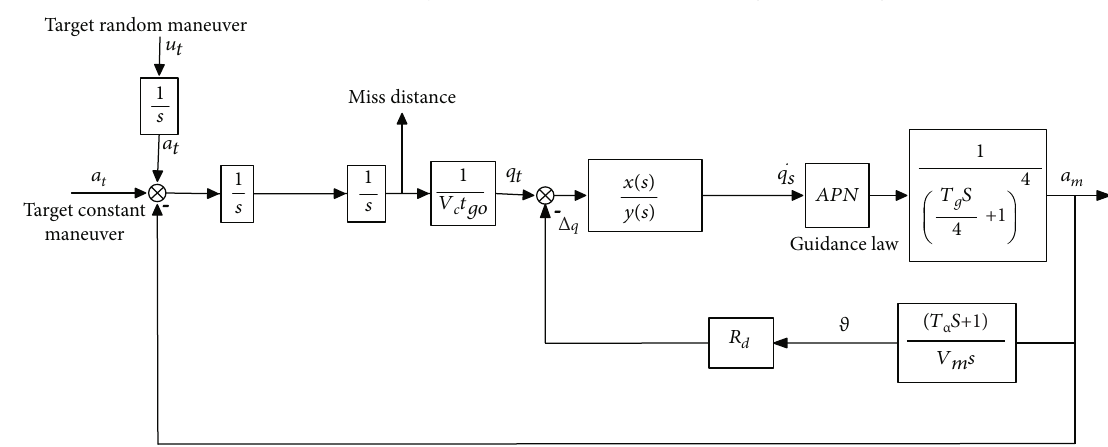
Figure 18: Guidance control system of the roll-pitch seeker considering typical error